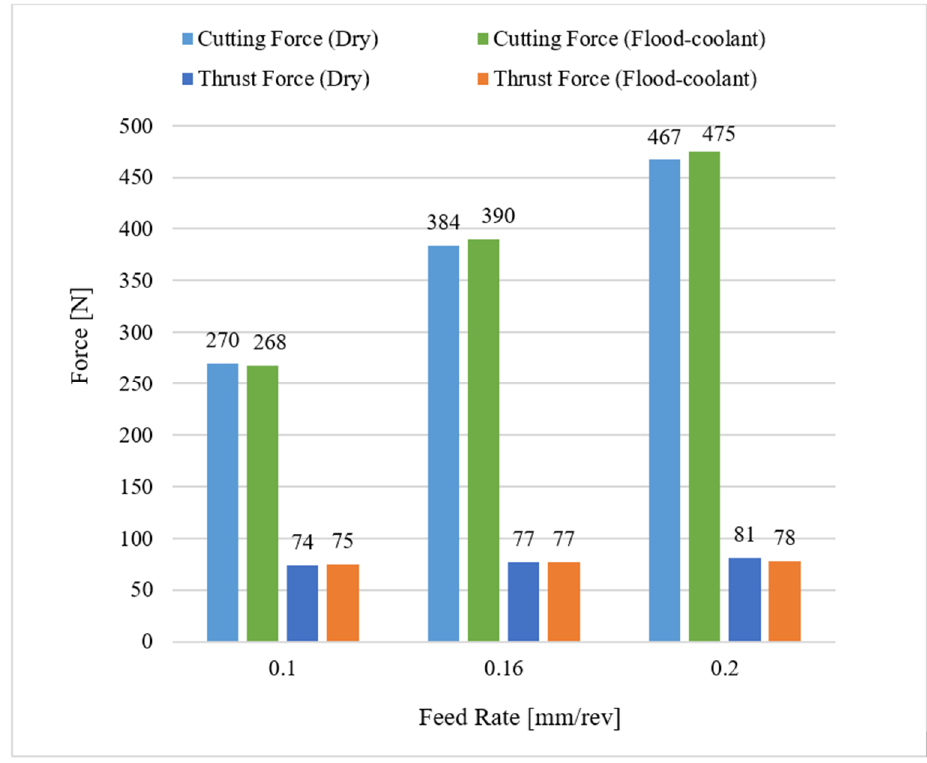
Figure 4. Variation of cutting and thrust forces with feed rate in dry and flood-coolant modes.